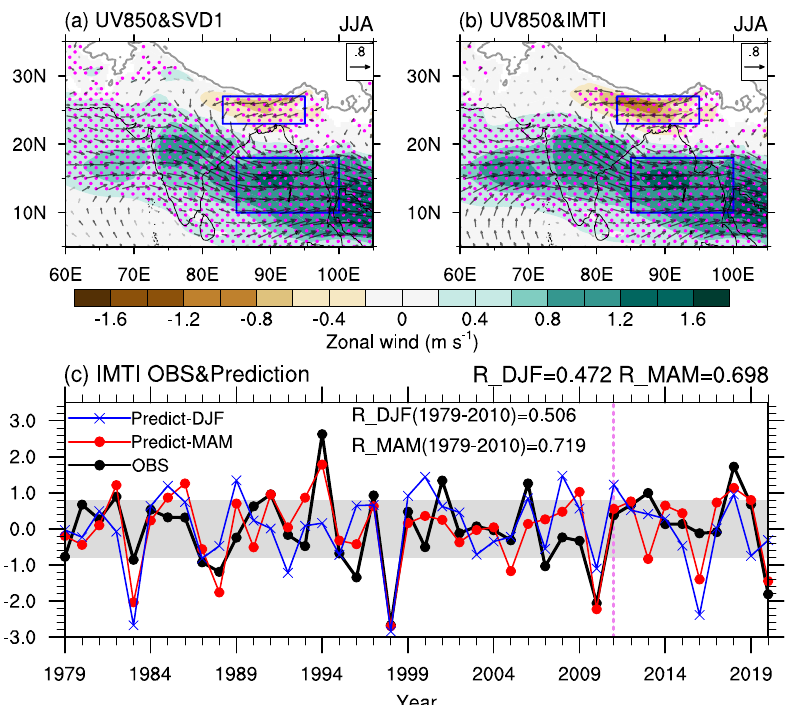
Fig. 3 | De fi nition and prediction of the Indian monsoon trough index (IMTI). Regressions of 850-hPawind (ms − 1 ;vector)against a the fi rst principal component (PC1) of rainfall and b IMTI. c Time series of the standardized IMTI in observation (black curve) and that predicted by the sea surface temperature over the eastern tropicalIndianOcean(TEIO_SST)andtropicalAtlantic(TA_SST)inprecedingspring (red curve) and by Niño-3 index in preceding winter (blue curve). In a , b shading denotes zonal wind. Signi fi cant values exceeding the 95% con fi dence level are marked by magenta dots or black vectors. The blue boxes outline the regions for